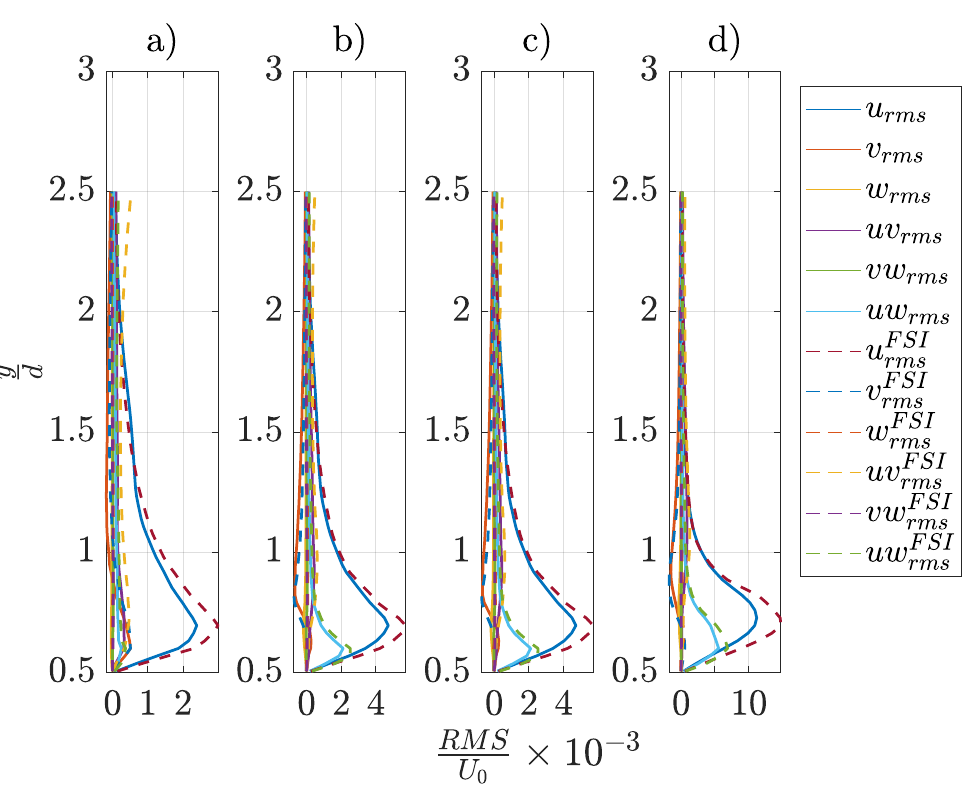
Figure 4. Profiles of turbulence intensities and square root of Reynolds shear stresses for the rigid case and the FSI case, respectively, at streamwise locations: ( a ) x = − 0.375 d , ( b ) x = − 0.125 d , ( c ) x = 0.25 d and ( d ) x = 0.5 d .